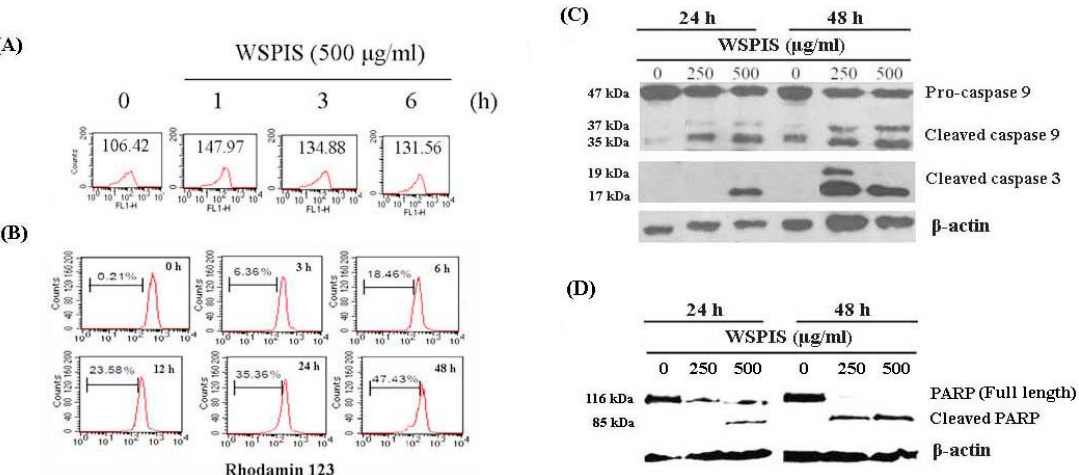
Figure 4. WSPIS induced the mitochondrial apoptotic pathway in THP-1 cells. ( A ) Effect of WSPIS on reactive oxygen species (ROS) production. Cells were treated with 500 μ g/mL WSPIS for 1, 3, and 6 h. Intracellular ROS was analyzed using flow cytometry after DCF-DA staining. ( B ) Effect of WSPIS on loss of the mitochondrial membrane potential (MMP). Cells were treated with WSPIS (500 μ g/mL) and harvested at the indicated times. The MMP was analyzed using flow cytometry after rhodamine 123 staining. ( C , D ) Analysis of the cleaved products of caspase-3, caspase-9, and poly(ADP-ribose) polymerase (PARP). Cells were treated with WSPIS (0, 250, and 500 μ g/mL) for 24 and 48 h, and the